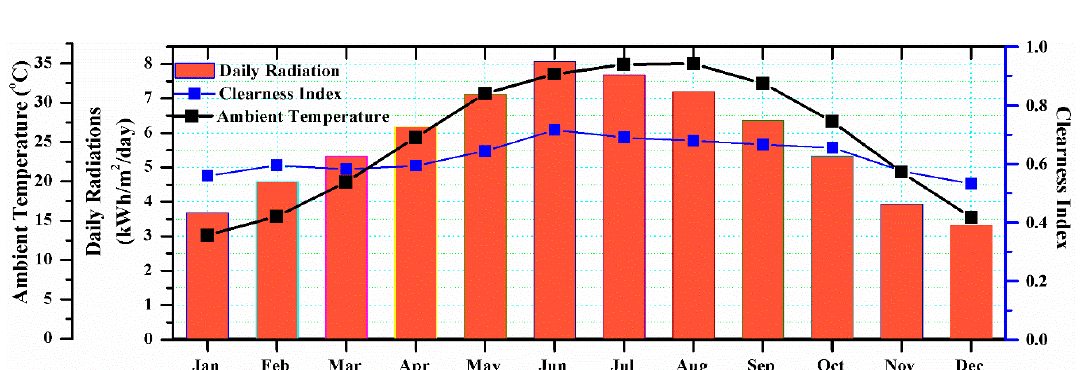
Figure 3. Temperature, Clearness Index and Irradiance of Majmaah University.